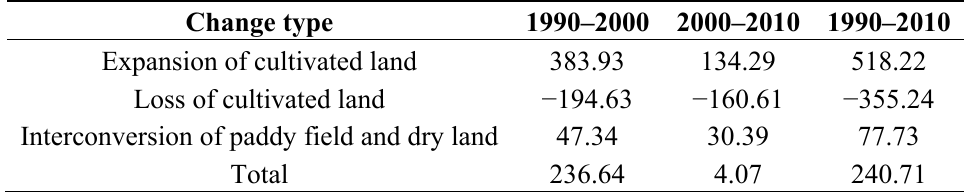
as affected by land-use changes (units, 1 × 10 4 t). Table 7. Changes in CR E